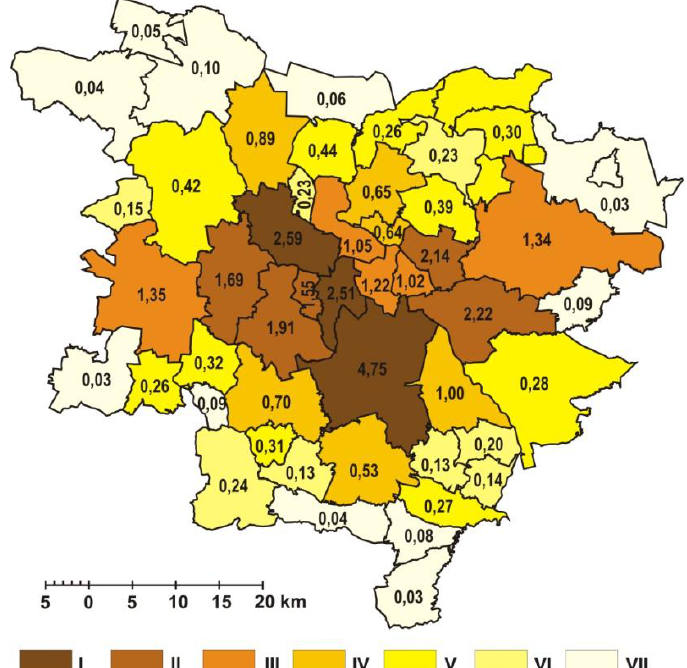
Fig. 4. The total number of inter-communities public transportation connections in the communities of the Katowice conurbation in 2008 average for all days of the week (own study) The number of connections in thousands: I – 4.00 and more; II – 2.01 – 4.00; III – 1.01 – 2.00; IV – 0.51 – 1.00; V – 0.21 – 0.50; VI – 0.11 – 0.20; VII – 0.10 and